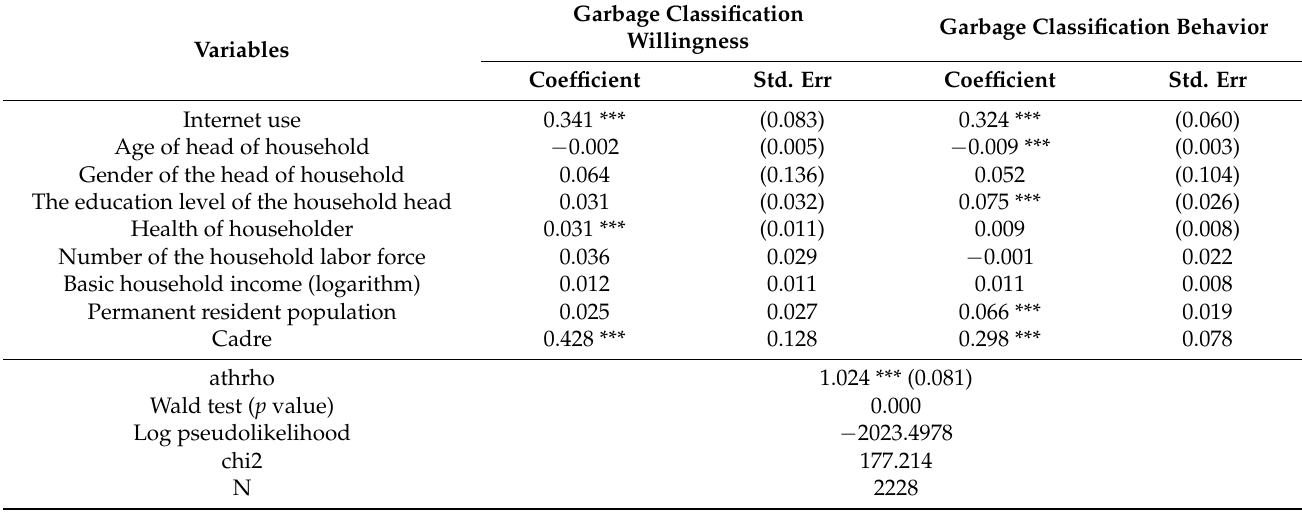
Table 2. Estimation results of the impact of internet use on farmers’ willingness and behavior in relation to garbage